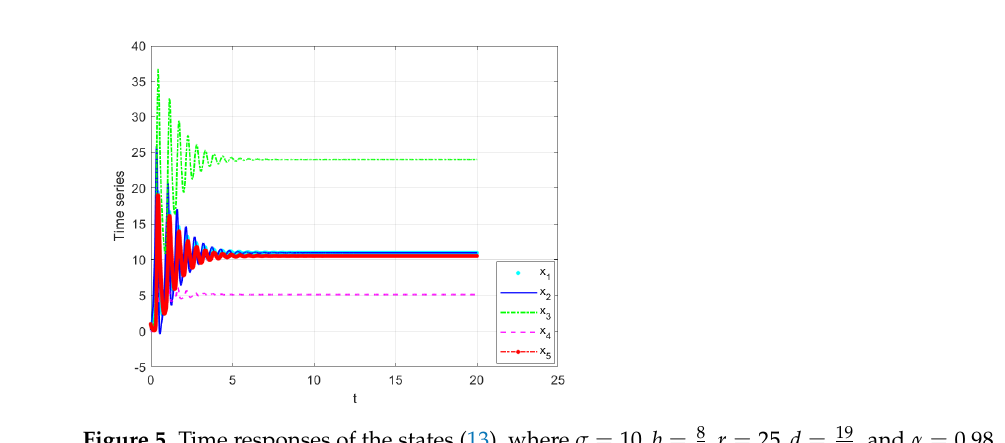
Figure 5. Time responses of the states (13), where σ = 10, b = 8